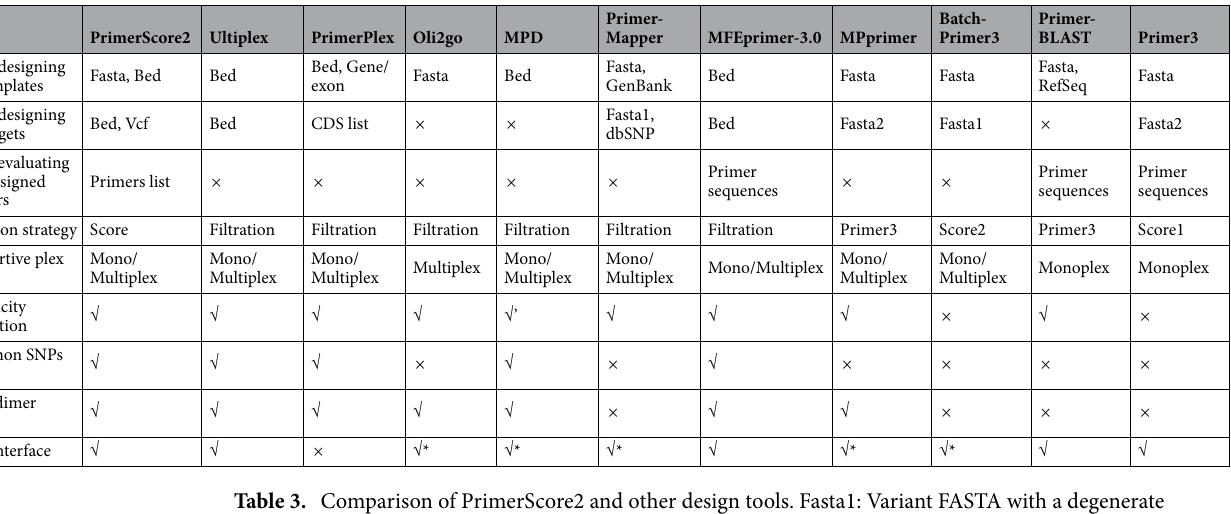
Table 3. Comparison of PrimerScore2 and other design tools. Fasta1: Variant FASTA with a degenerate SNP in the middle of the sequence. Fasta2: FASTA, targets are specified by position on the sequence and length. Score1: Calculating penalty score only for basic features, not for specificity or common SNPs. Score2: Calculating score only for basic features, not for specificity or common SNPs. √’: By quality score of k -mer uniqueness. √*: Connection failed.